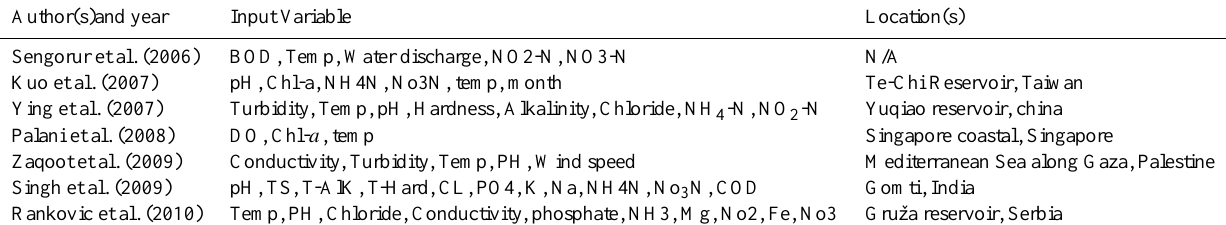
Table 1. Input parameters used in previous studies for the ANN model.